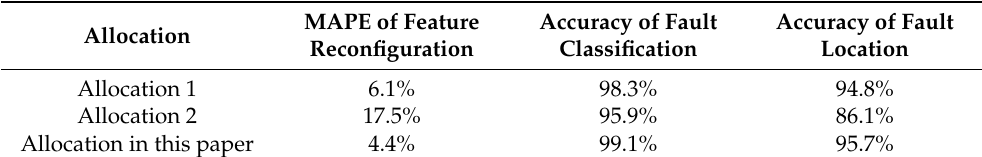
Table 4. Comparison results of different µ PMU allocations.